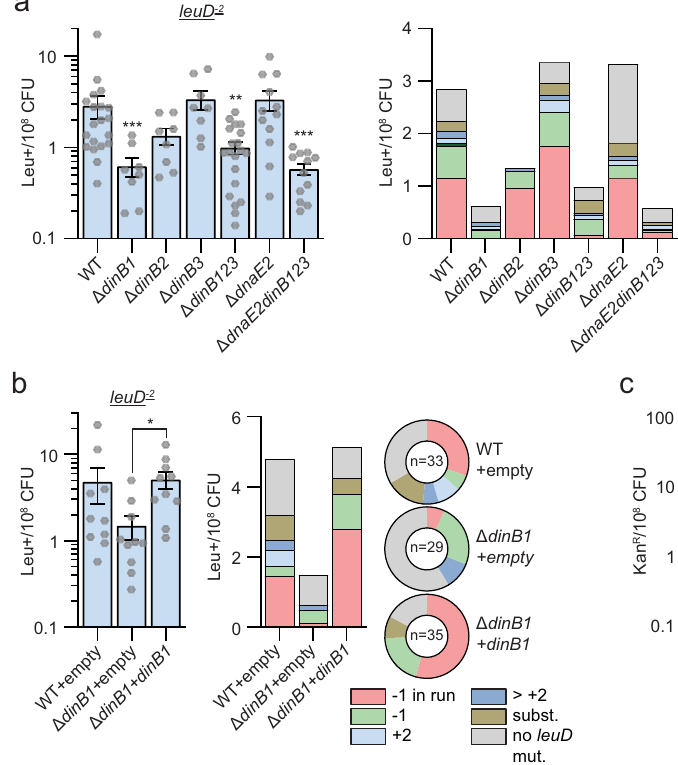
Fig. 6 | DinB1 is the primary mediator ofspontaneous − 1 frameshift mutations in homo-oligonucleotide runs. a , b leu + or c kan R frequency in the indicated strains and relative (pie chart) or absolute (bar chart) frequencies of nucleotide changes detected in leuD or kan codedby color. The number ofsequenced leu + or kan R colonies is given in the center of each pie chart. Results shown are means (±